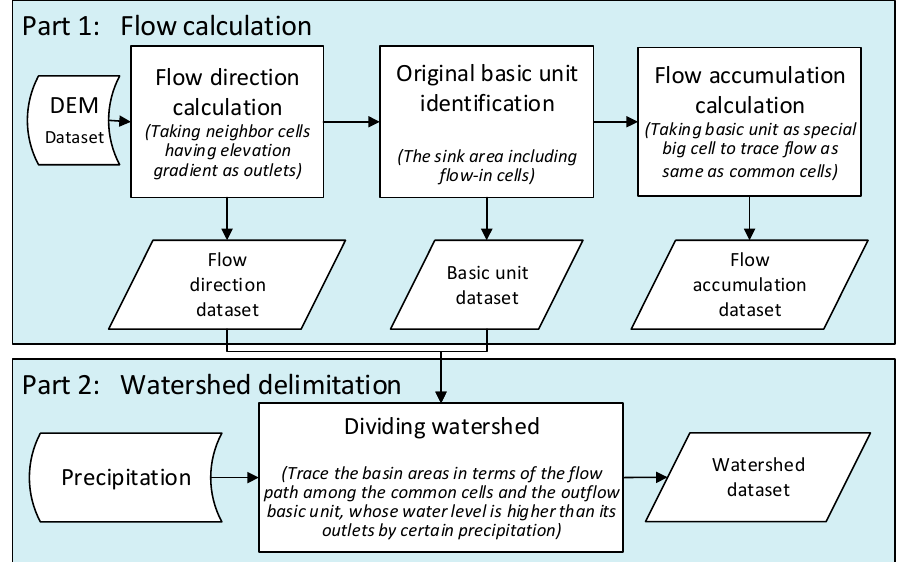
Figure 2. The process of the proposed watershed delimitation method. It is comprised of two main parts: (1) flow calculation according to a no-fill digital elevation model (DEM) and (2) watershed delimitation in terms of precipitation, flow direction, and basic unit datasets.